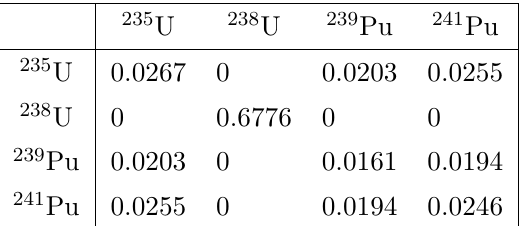
detector at 34 m from the same reactor of the Krasnoyarsk87-33 experiment [72]. There may be reactor-related uncertainties correlated among the four Krasnoyarsk experiments, but, taking into account the time separations and the absence of any information, we conservatively neglected